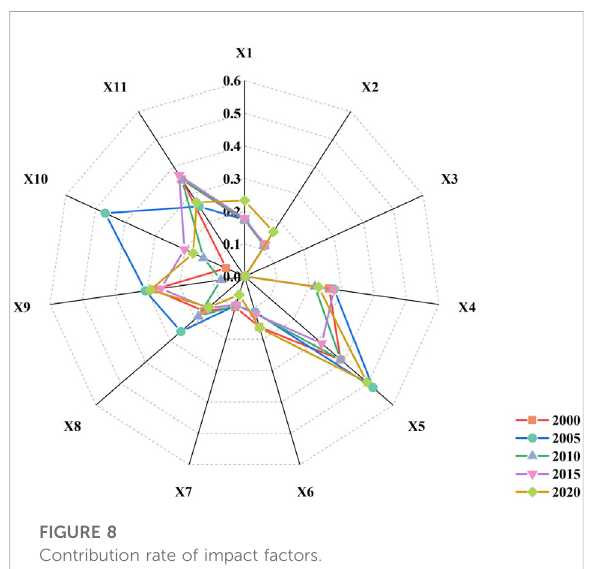
FIGURE 8 Contribution rate of impact